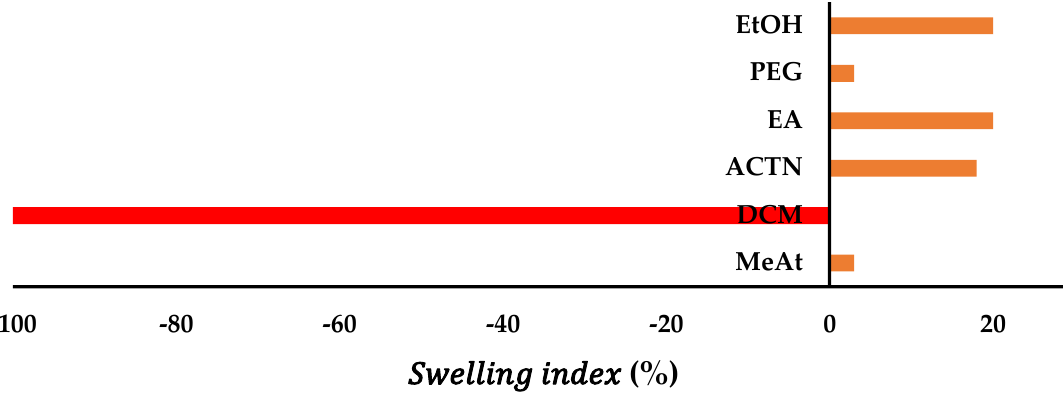
Figure 3. Swelling index percentage of PLA in the selected organic solvents.